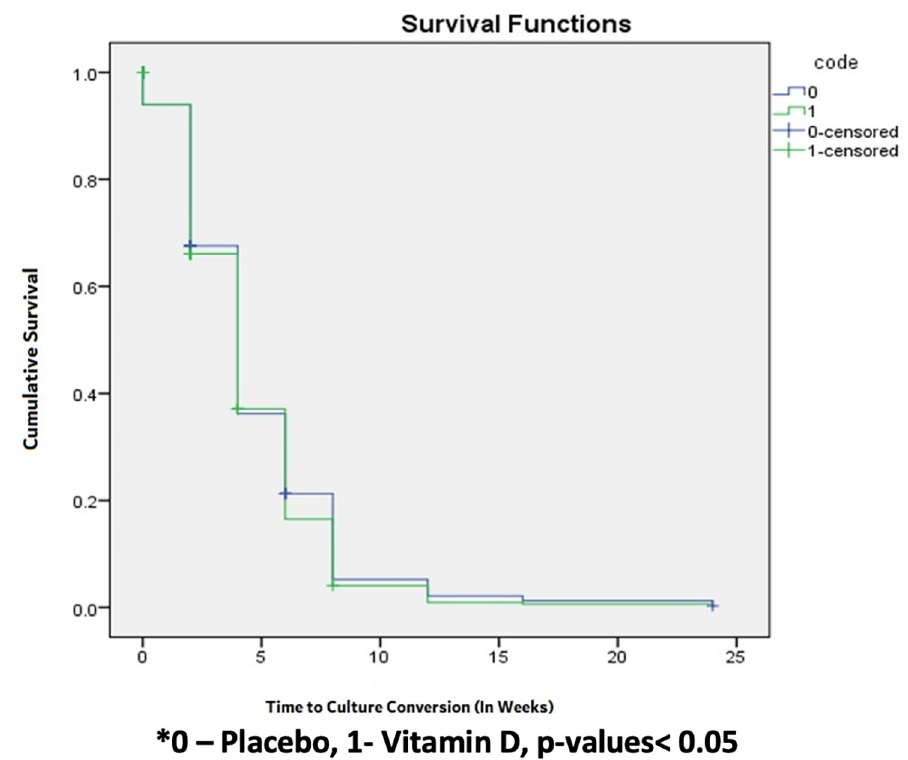
Fig 4. Kaplan Meier graph presenting time to culture conversion in both the groups. Shows Time to conversion of sputum culture in both group Vitamin D and Placebo. There is no significant difference in the Time to conversion of (sputum culture) MGIT with p-value is